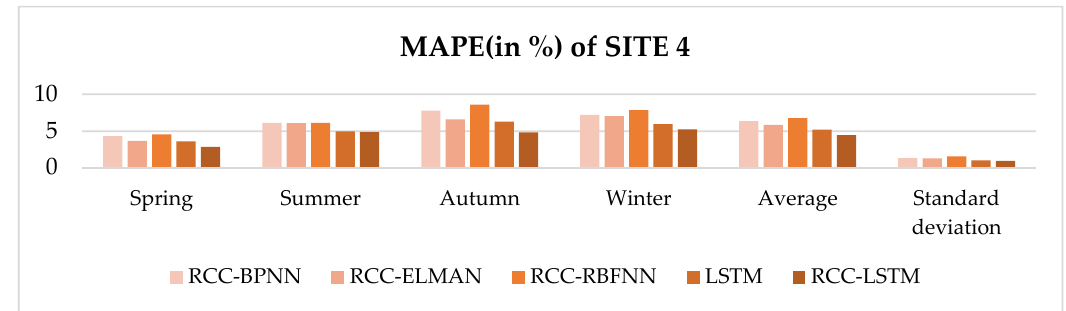
Figure 14. Comparative MAPE (in %) results of SITE 4.